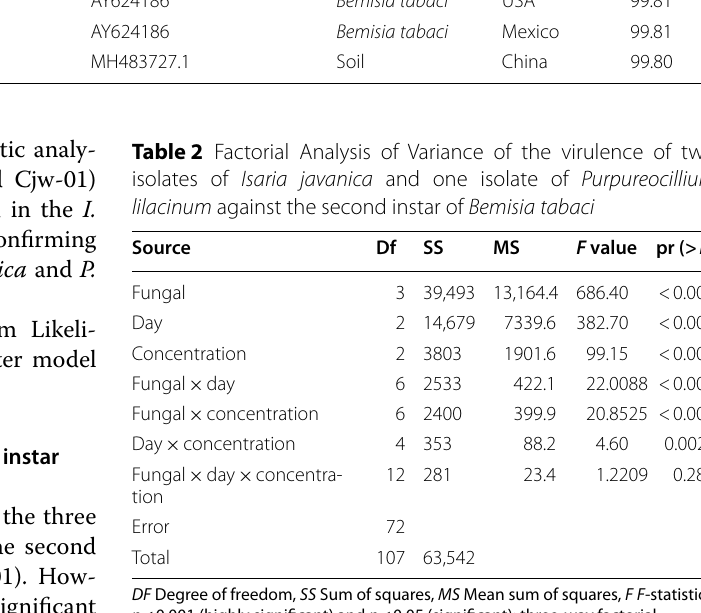
DF Degree of freedom, SS Sum of squares, MS Mean sum of squares, F F -statistic, p < 0.001 (highly significant) and p < 0.05 (significant); three-way factorial analysis of variance (ANOVA) at α =